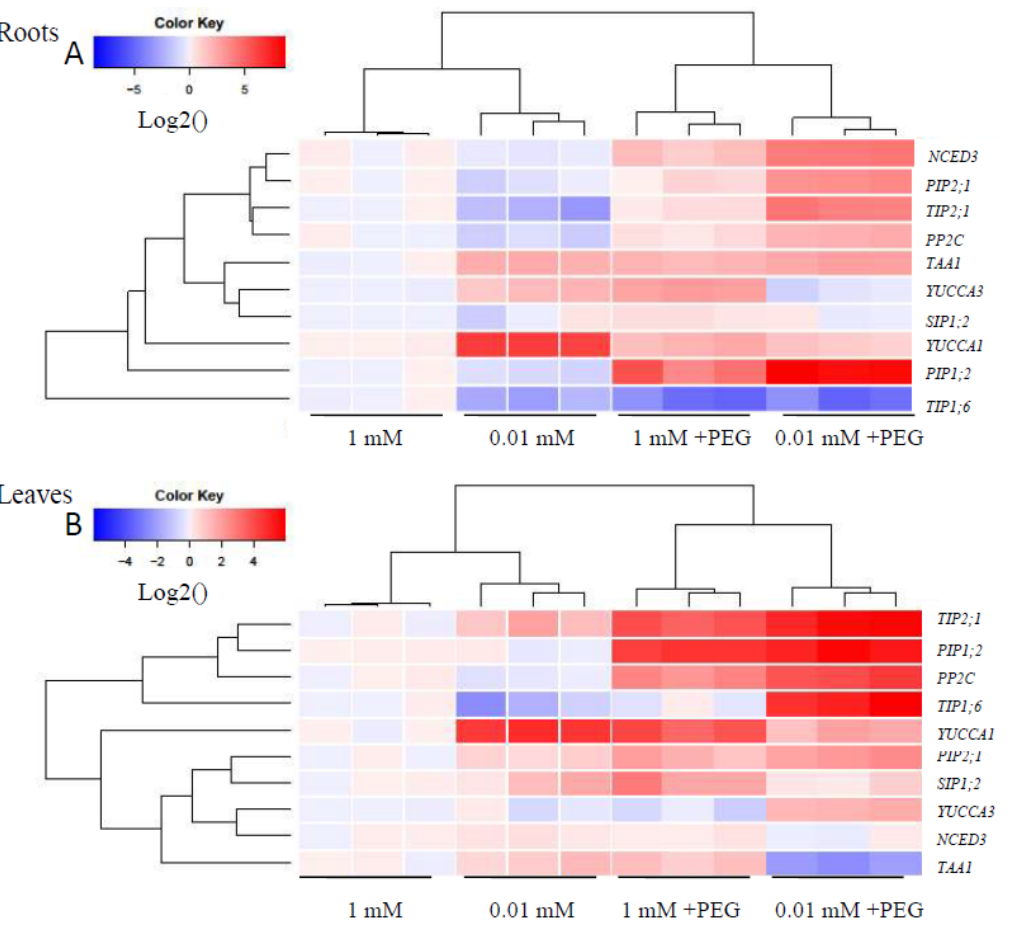
Figure 8. Fold changes of transcript levels of AQPs and representative genes involved in IAA and ABA signaling pathways in roots ( A ) and leaves ( B ) of Populus simonii as affected by nitrogen supply and drought stress. Signal intensities were calibrated according to a constitutively expressed poplar actin gene [10].